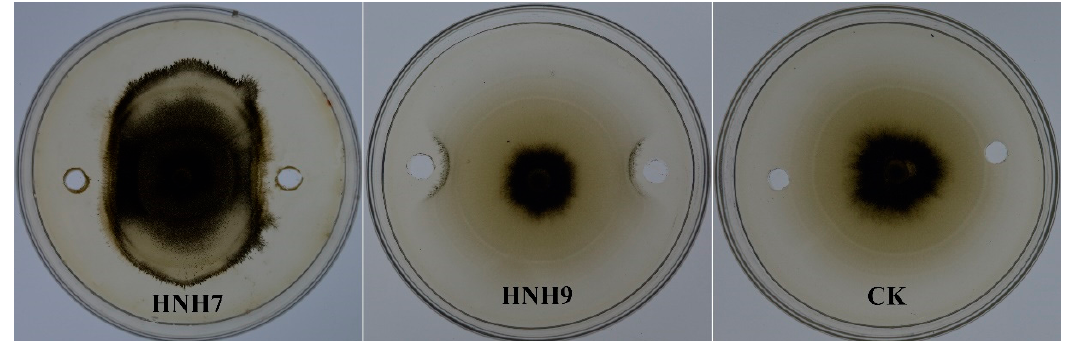
Figure 3. Antifungal effect of crude extracts from endophytic Bacillus strains HNH7 and HNH9 against VD-080.